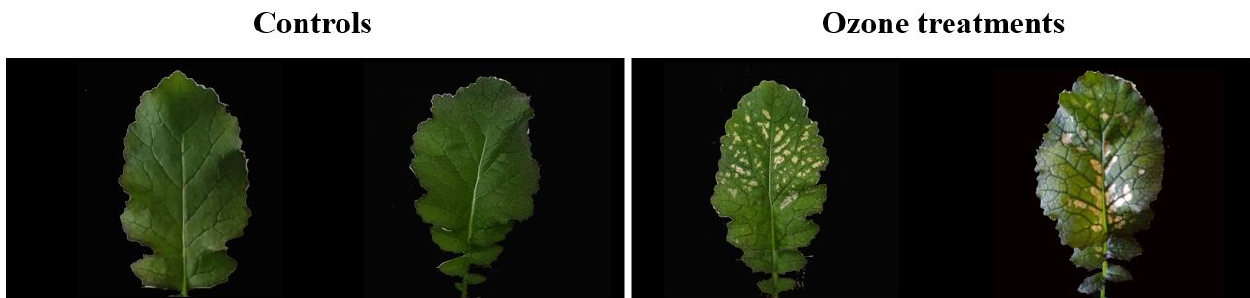
Figure 3. The visible symptoms of O 3 damage under an O 3 concentration of 100 nL L − 1 at 14 days after exposure. Photos from Lee et al. [24].